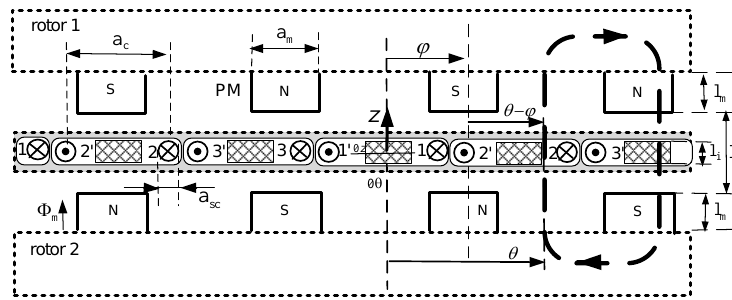
Figure 6. Model for the analysis of Axial Flux Permanent Magnet Generator (AFPMG) magnetic flux-density distribution with stator cores.